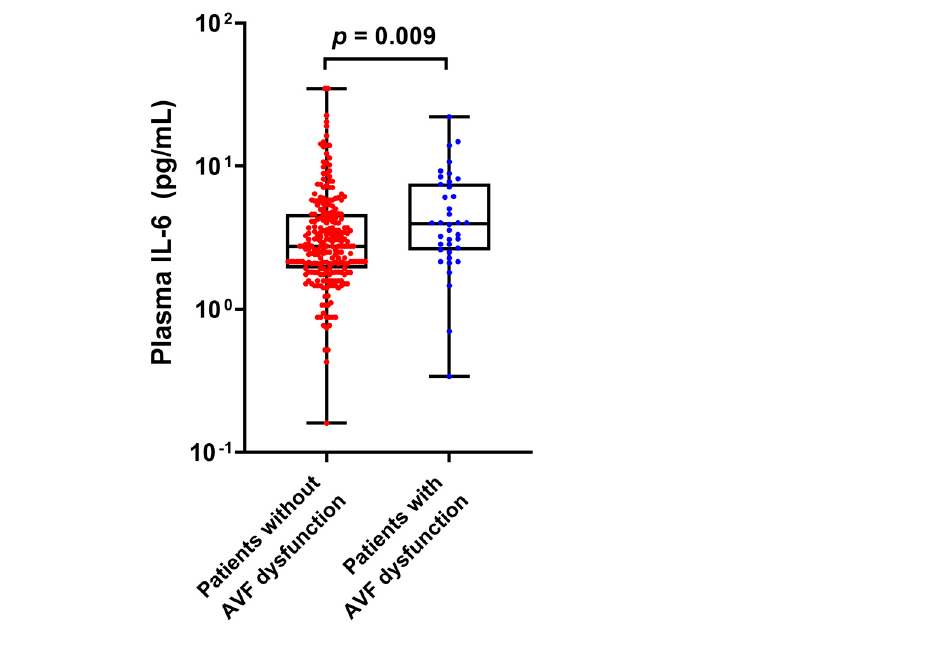
Table 2. Multivariable analysis for the prediction of arteriovenous fistula dysfunction .